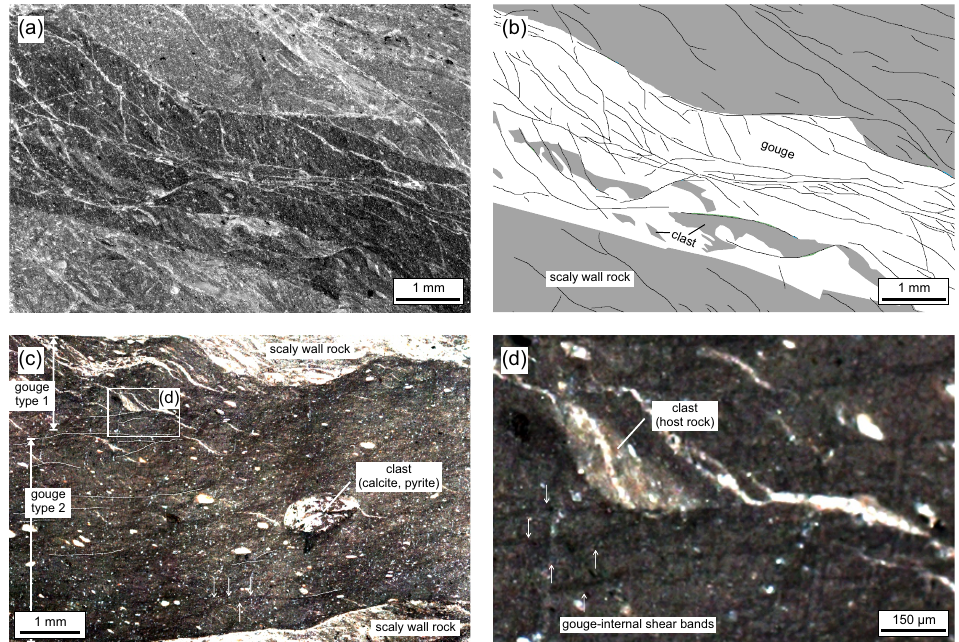
Figure 8. Series of shear zones within gouge and surrounding wall rock (scaly clay) as well as host rock clasts. (a, c, d) Reflected light micrographs, (b) sketch of panel (a) and (d) inset of panel (c) . Dashed lines and arrows mark the wavy net of dark shear bands, which are wider than micrometer-thin shear zones (see Fig. 11). (a, b) Sample A3-1 polished with 800 grid grinding paper and (c, d) sample V15-T2 polished using a large-area BIB. The images are contrast enhanced to make the black bands stand out. Best viewed in a high-quality color print or as a magnified pdf. See text for